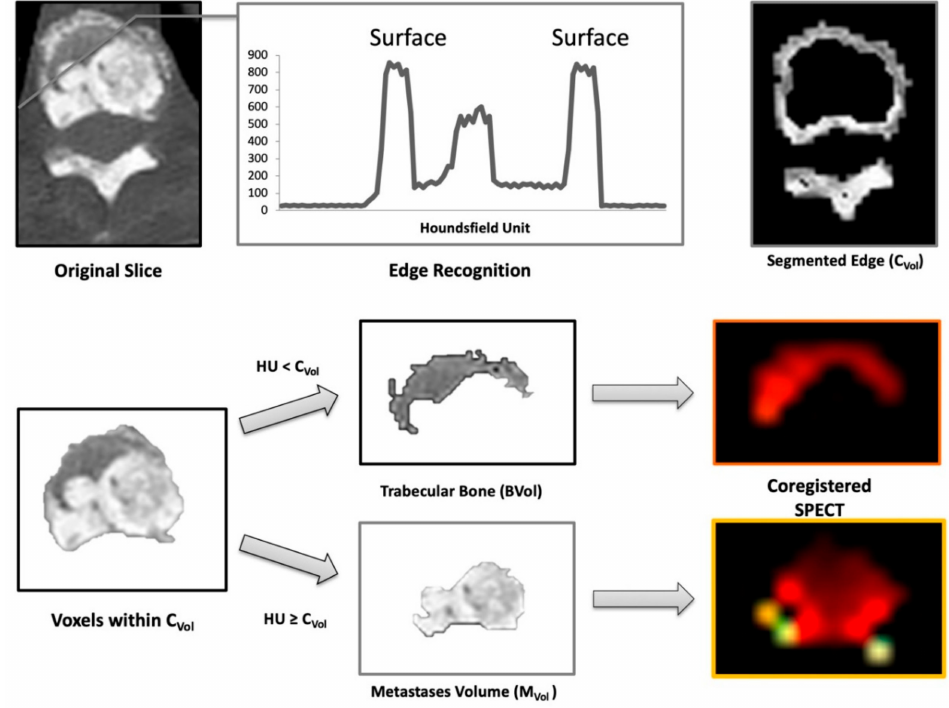
Figure 5. Functioning of the segmentation process. The software analyzes sequentially the Hounsfield Unit (HU) density of voxel within a single slice (top left). The bone border is identified as an increase of HU values (top center). After definition of the cortical volume (C Vol , top right), its mean HU density is calculated. This value is used to classify all voxels located on the inside of C Vol as pertinent to bone metastases (M Vol ) or to normal trabecular bone (B Vol , middle and left bottom panels). Afterwards, mean counts / voxel are extracted from the co-registered images (bottom